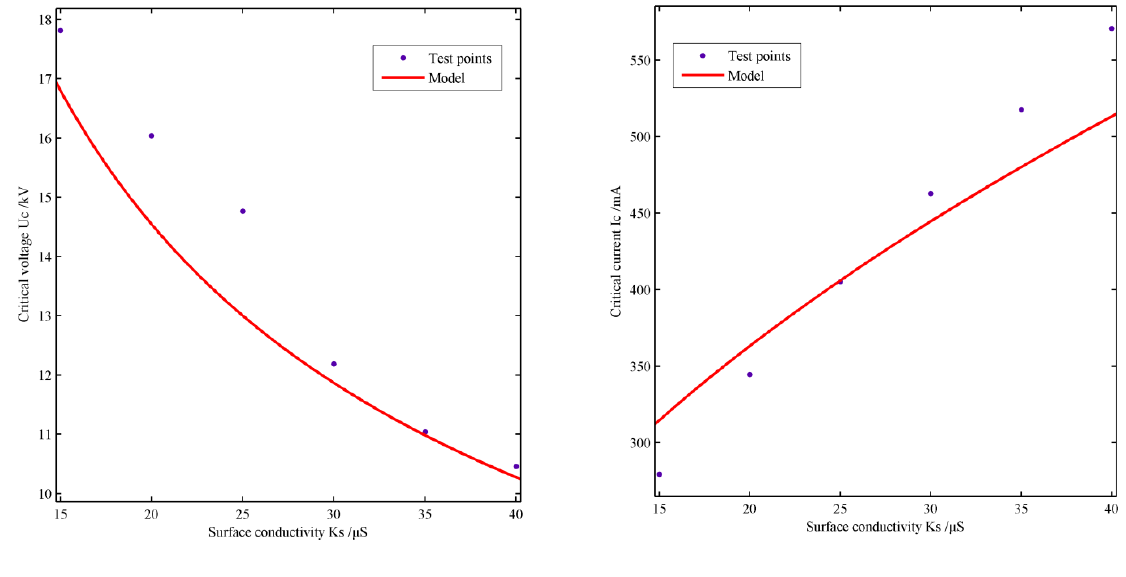
Figure 11. The comparison between the proposed model and experiments on XP ( a ) Critical flashover voltage varies with the surface conductivity; ( b ) Critical flashover current varies with the surface